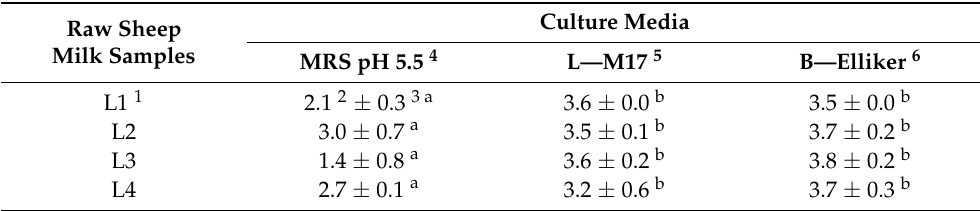
Table 1. Viable colony counts (log 10 CFU/mL, mean ± standard deviation) of thermophilic LABs from Sardinian raw sheep milk samples plated on MRS pH 5.5, L-M17, and B-Elliker in aerobic conditions at 45 ◦